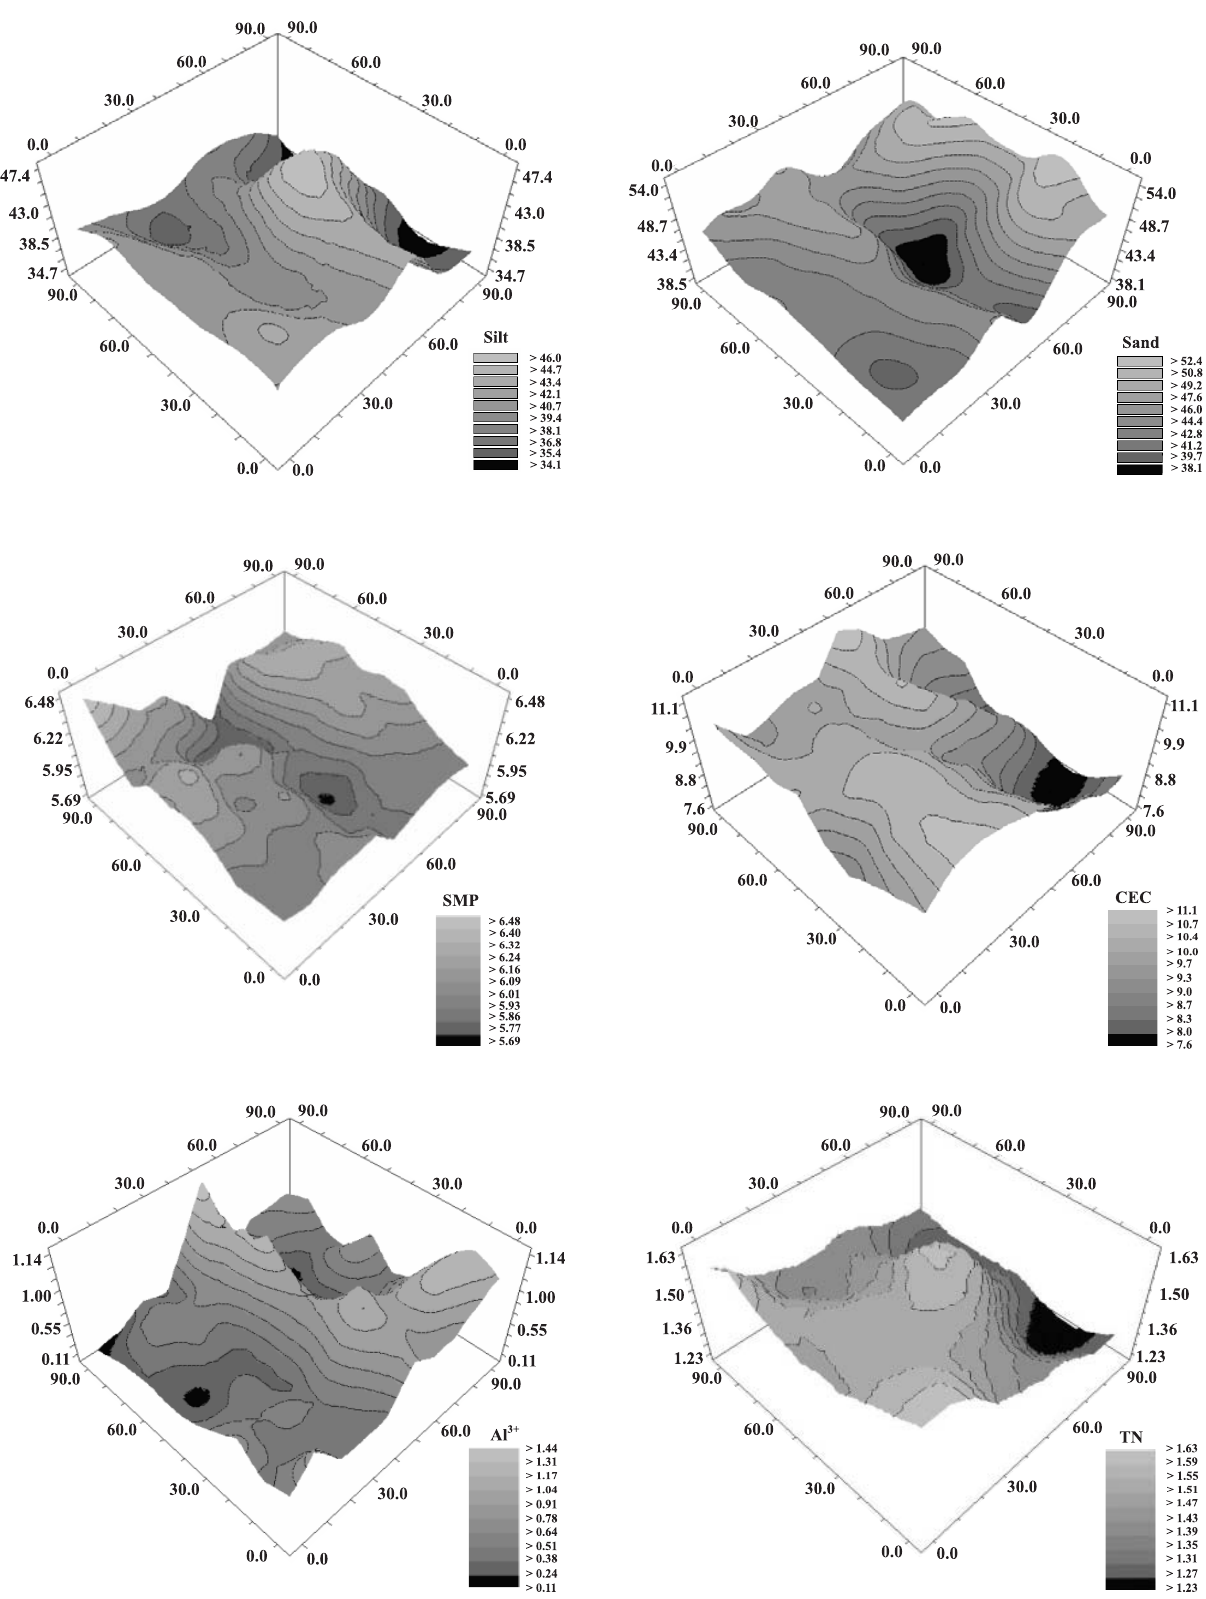
Figure 3. Maps of the spatial distribution of silt, sand, SMP index, CEC, Al 3+ and TN soil properties with the spatial structure properly determined in a lowland soil cultivated with irrigated